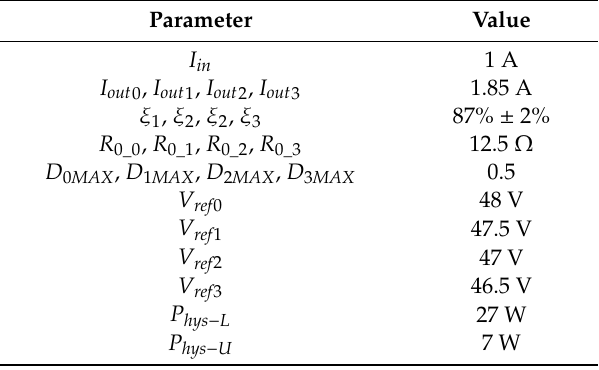
Table 1. Parameters of four-module-stack